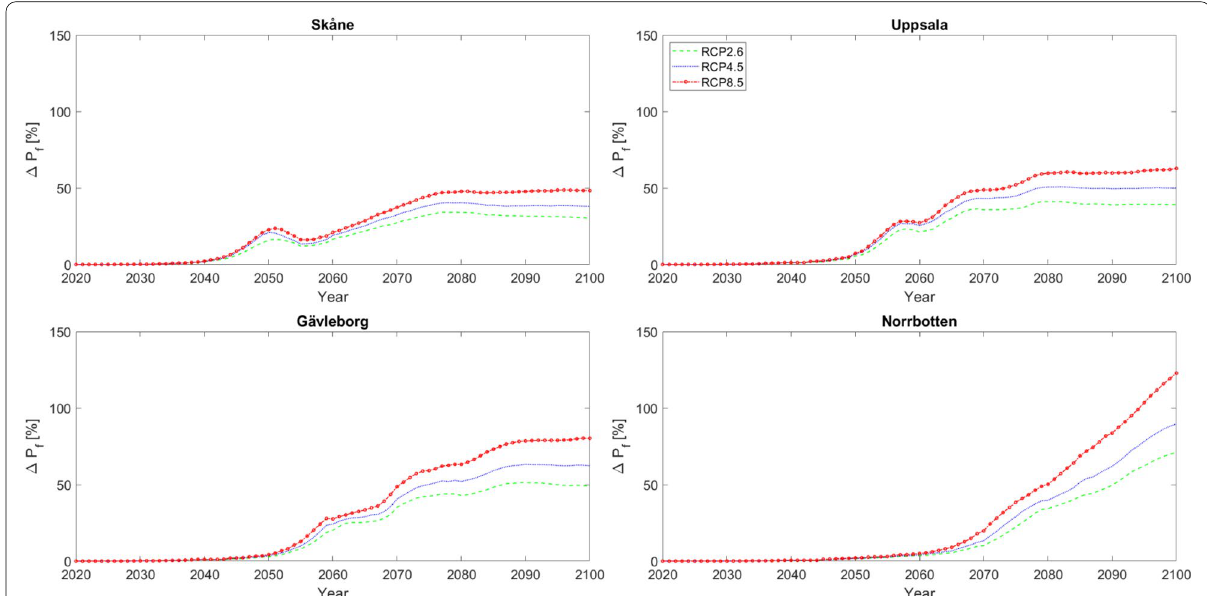
Fig. 9 Percentage change in the probability of failure for the studied beam under the future climatic conditions compared to the historical climate (1961 –